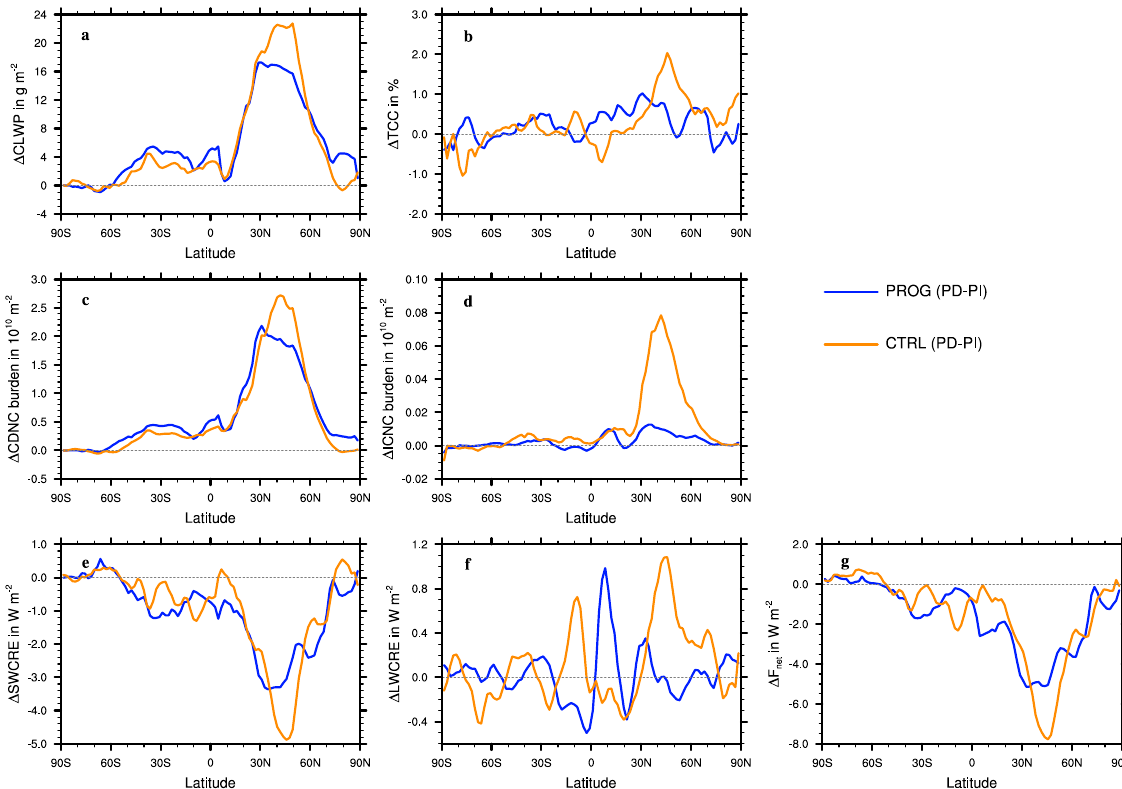
Figure 14. Zonal annual mean difference between PD and PI of (a) liquid water path, (b) total cloud cover, (c) the CDNC and (d) ICNC burden, (e) shortwave, (f) long-wave and (g) net TOA cloud radiative forcing for CTRL and PROG for the years